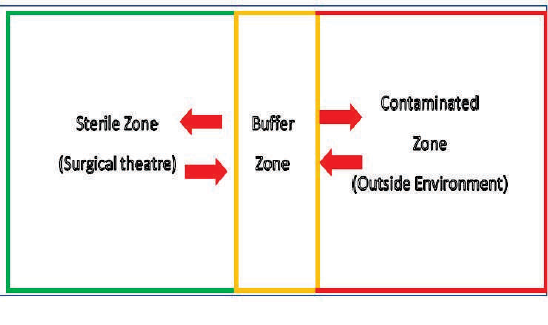
Figure 3: Concept based on surgical operating theatre setting